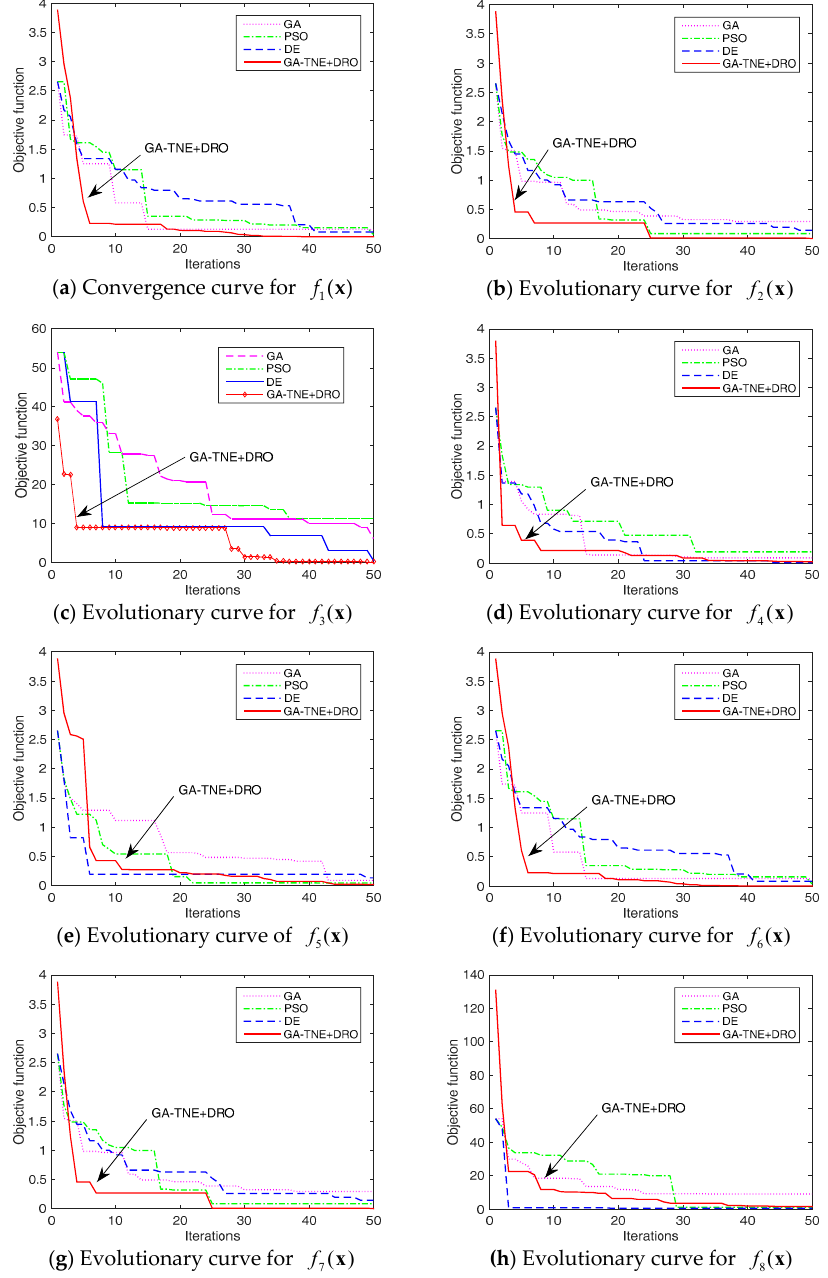
Figure 6. Evolution curves of benchmark functions.